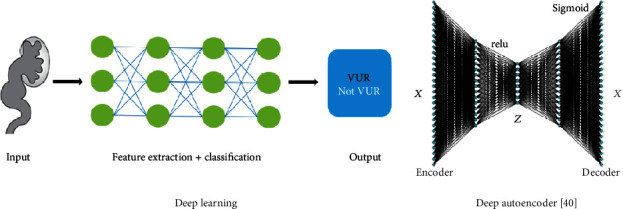
Deep learning. Deep autoencoder [40].